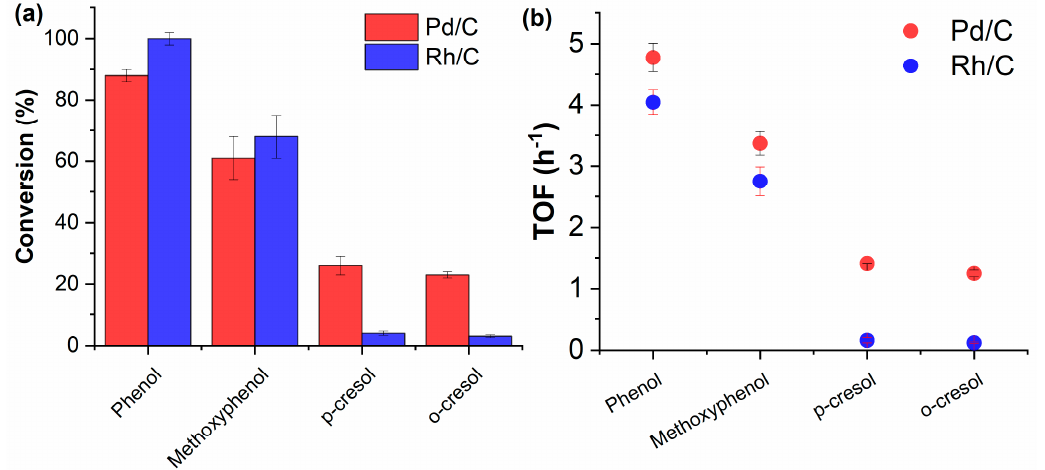
Figure 7. ( a ) TOF (h − 1 ) and ( b ) Conversion for substituted phenols on Rh/C and Pd/C. The TOFs are calculated from the average reaction rates of phenolics conversion curves. The reactions were carried out using H 2 gas (1.5 bar), C 0Phenolic = 0.2 mol/L, CyA (1.5 Eq to PhOH) and 120 °C with t R = 6 h.